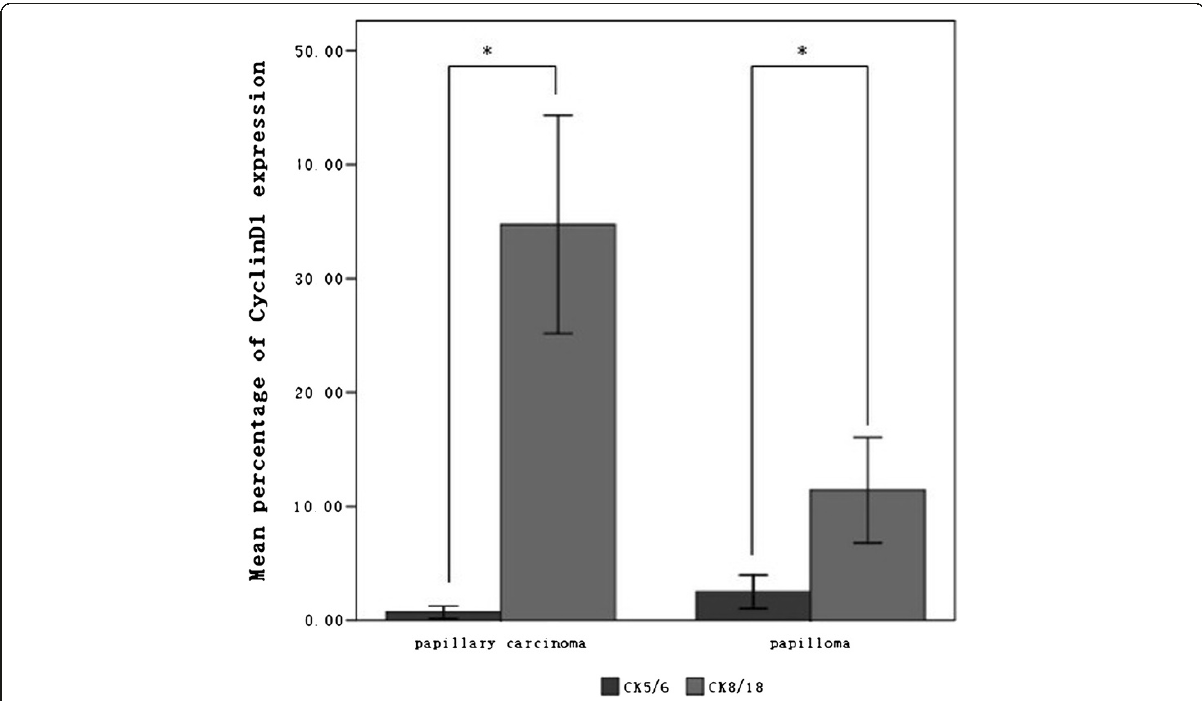
Figure 3 The mean co-expression rate of Cyclin D1with CK 5/6 or CK 8/18 in papilloma and papillary carcinoma cells. The mean co-expression rate of Cyclin D1 with CK 8/18 was 11.42% ± 10.17%, and that with CK 5/6 was 2.50% ± 3.24% (p < 0.01); whereas in papillary carcinomas, the mean co-expression rate of Cyclin D1 with CK 8/18 was 34.74% ± 16.32%, and that with CK 5/6 was 0.70% ± 0.93% (p < 0.01). The values are expressed as (cid:1) X ±SD.*P < 0.01 (Mann – Whitney U test). The differences exhibited statistical